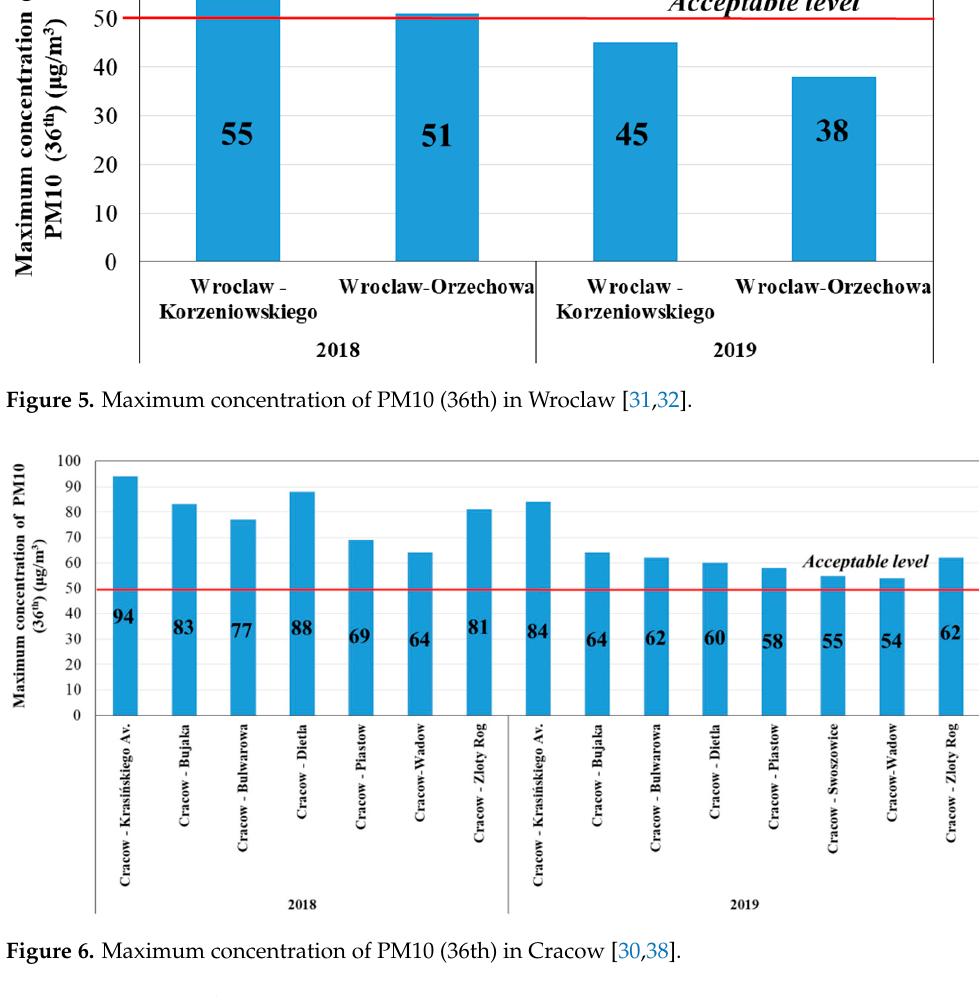
Figure 6. Maximum concentration of PM10 (36th) in Cracow [30,38].